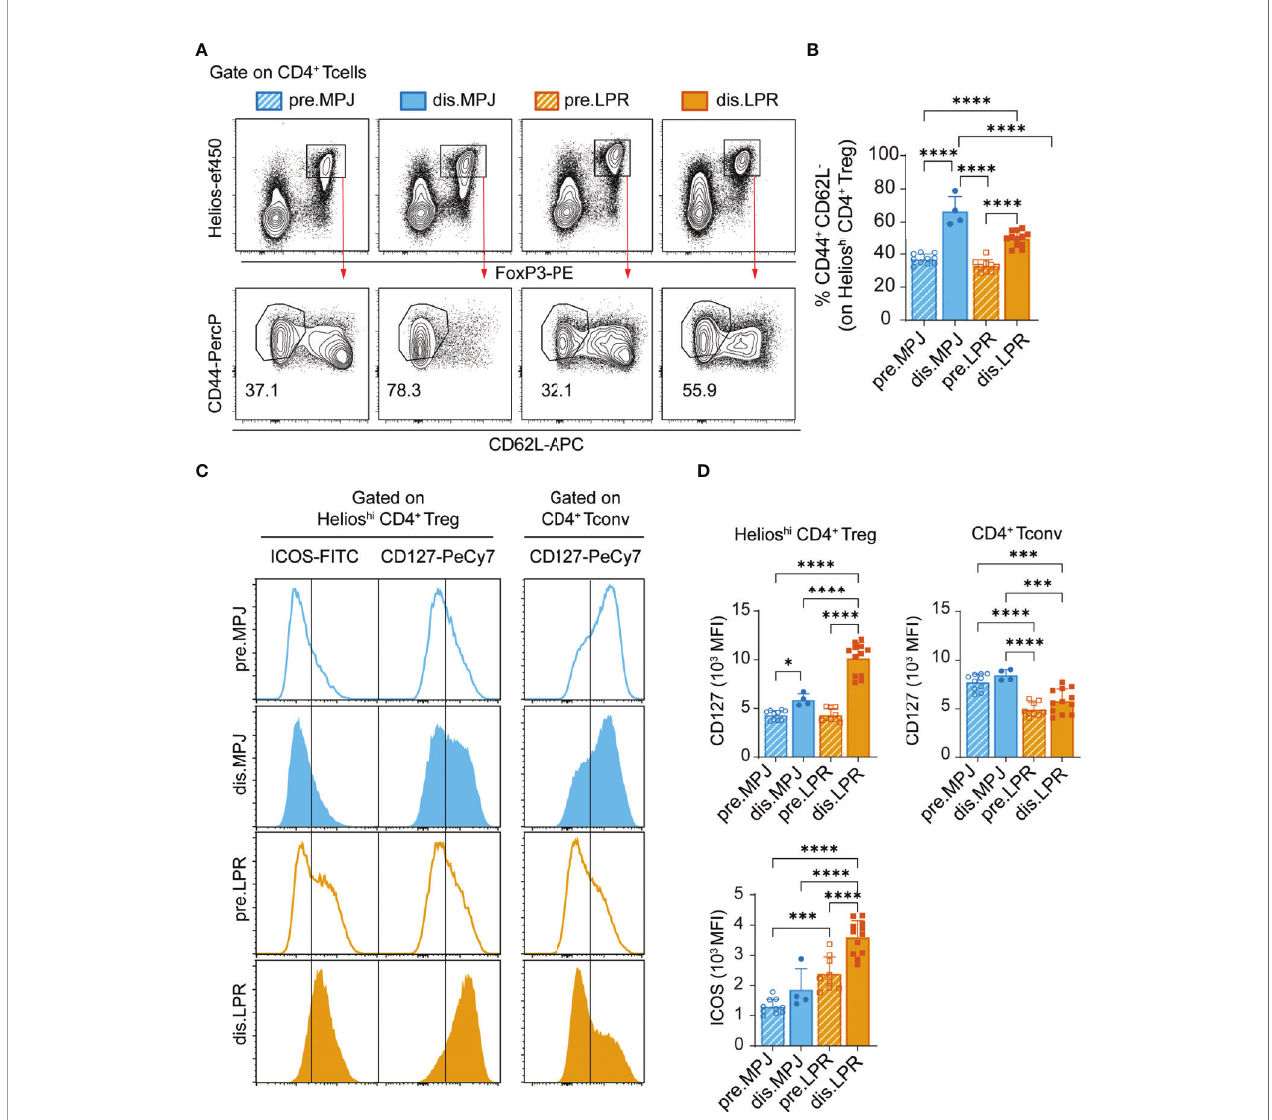
FIGURE 3 | Helios expression and effector phenotype of CD4 + Tregs in MPJ and LPR mice. (A) Representative fl ow cytometry plots pregated on splenic CD4 + T cells (CD3 + CD4 + ), in which Treg (FoxP3 + Helios hi , top) and their effector (CD44 + CD62L − ) populations (bottom) are indicated. (B) Percentage of splenic CD4 + Treg cells with an effector phenotype. (C) Representative ICOS and CD127 histograms gated on CD4 + Treg (left) and CD4 + Tconv (right). (D) MFI quanti fi cation of ( C ). The data represent the mean ± SD: *P < 0.05; ***P < 0.001; ****;P < 0.0001 by one-way ANOVA with a Tukey multi-comparison post-test. Each point represents a single animal: prediseased MPJ (pre.MPJ), n = 10 (A – D) diseased MPJ (dis.MPJ), n = 4 (A – D) prediseased LPR (pre.LPR), n = 9 (A – D) and diseased LPR (dis.LPR), n = 12 (A – D)